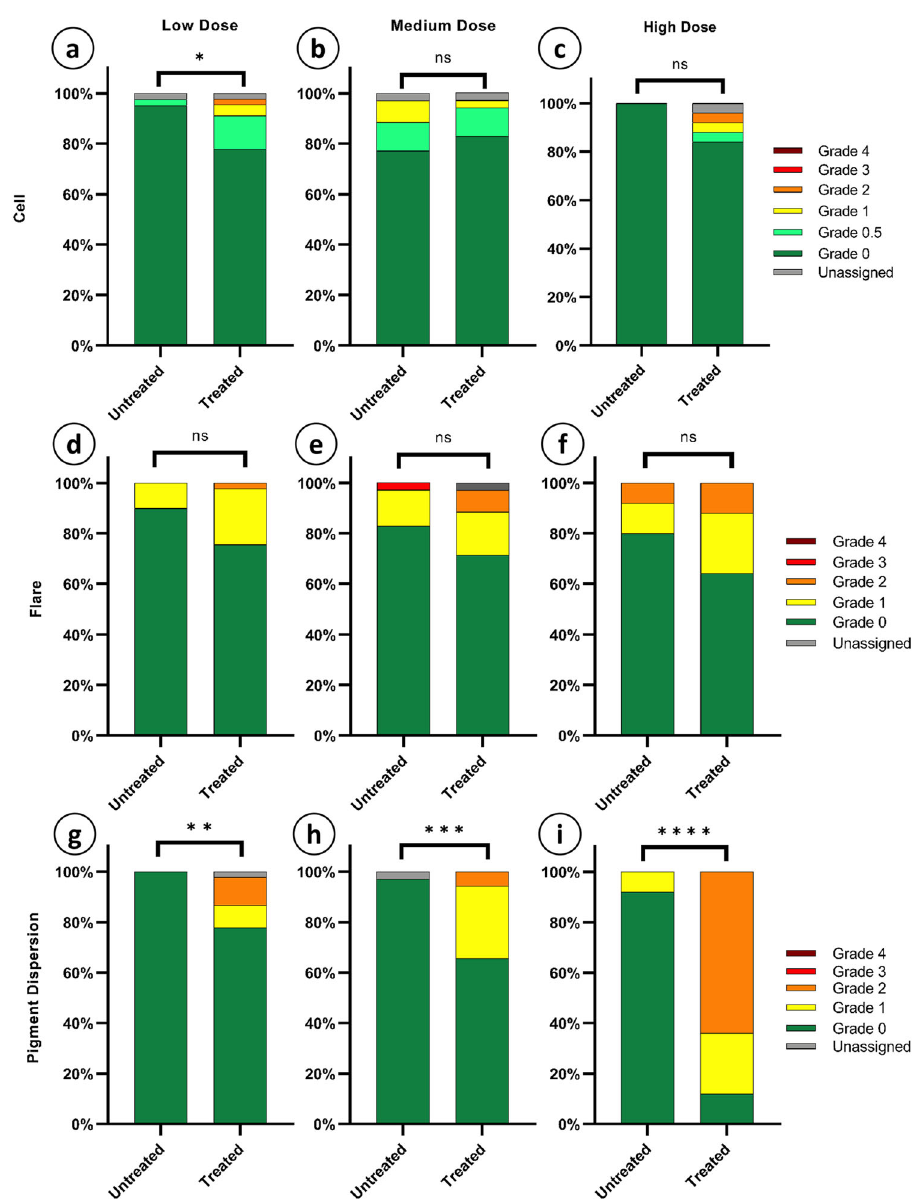
Fig. 6 Slit lamp evaluation of treated vs. untreated eyes at 12 months. Slit lamp examination photographs graded by 5 masked participants were compared between untreated and treated eyes for each dosage group for cell ( a – c ), fl are ( d – f ), and iris pigment dispersion ( g – i ). A Fisher ’ s exact test revealed that in the case of low dose cell ( a ), cell presence was dependent on vector administration, but not for medium or high dosage groups ( b , c ). In all cases of fl are, the Fisher ’ s exact test revealed that fl are score is independent of vector administration ( d – f ). Similarly, all dosage groups exhibited increased iris exfoliation that was dependent on vector administration ( g – i ). (Fisher ’ s exact test: p -values = 0.0165 ( a ), 0.7516 ( b ), 0.1099 ( c ), 0.0952 ( d ), 0.3938 ( e ), 0.2451 ( f ), 0.0011 ( g ), 0.002 ( h ), and <0.001 ( i ). N = 9, 7, and 5 for low, medium, and high dose